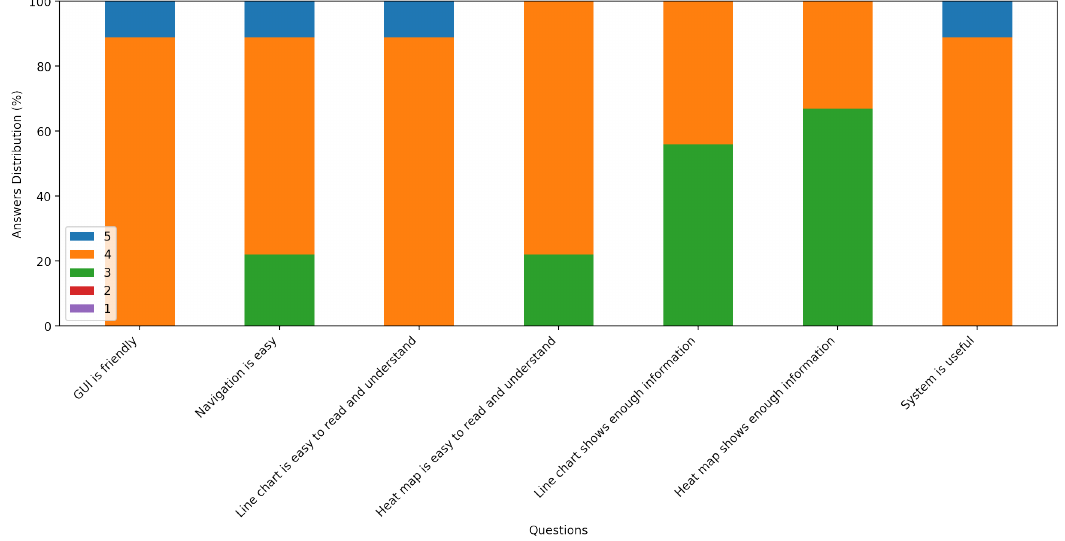
Figure 17. The statistical result of the